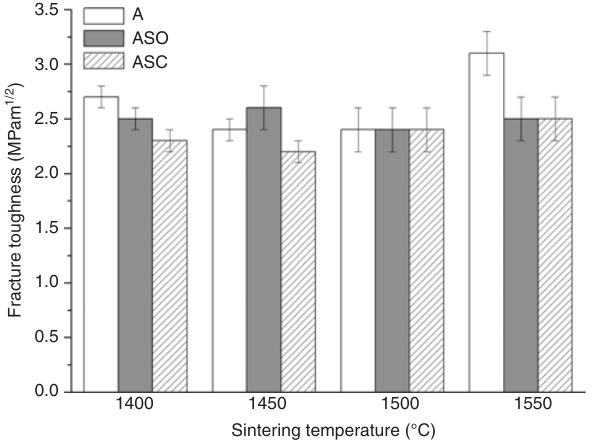
of mullite formed or the more homogeneous distribution of mullite in the ASC ceramic sample [16, 17]. Figure 6 shows the graph of fracture toughness versus sintering temperature. It can be seen that there is no significant difference in fracture toughness between alumina and alumina-based composites. The value of fracture tough- ness of alumina sintered at 1550 ° C is higher than the other samples because of the high value of ( E / H ) 1/2 . In this work, V the calculated volume fraction of mullite in the compos- ites is ~ 14% (from the reaction sintering with 6 wt% SiO 2 from direct addition or oxidation) and the result of hard- ness and fracture toughness can be compared with the report from Luo et al. [17] and Svancarek et al. [16]. The value of hardness is agreeable and the value of fracture toughness is slightly lower because the calculation in this work takes the effect of porosity into account